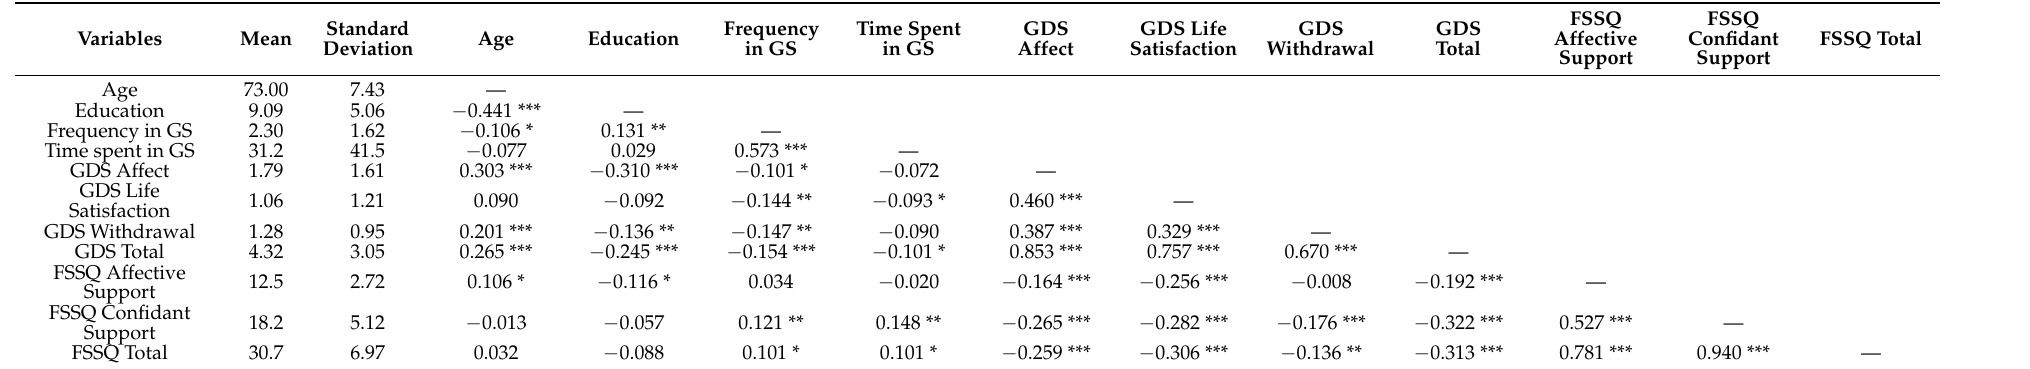
Table 1. Means, Standard Deviations, and Correlations of variables included in the